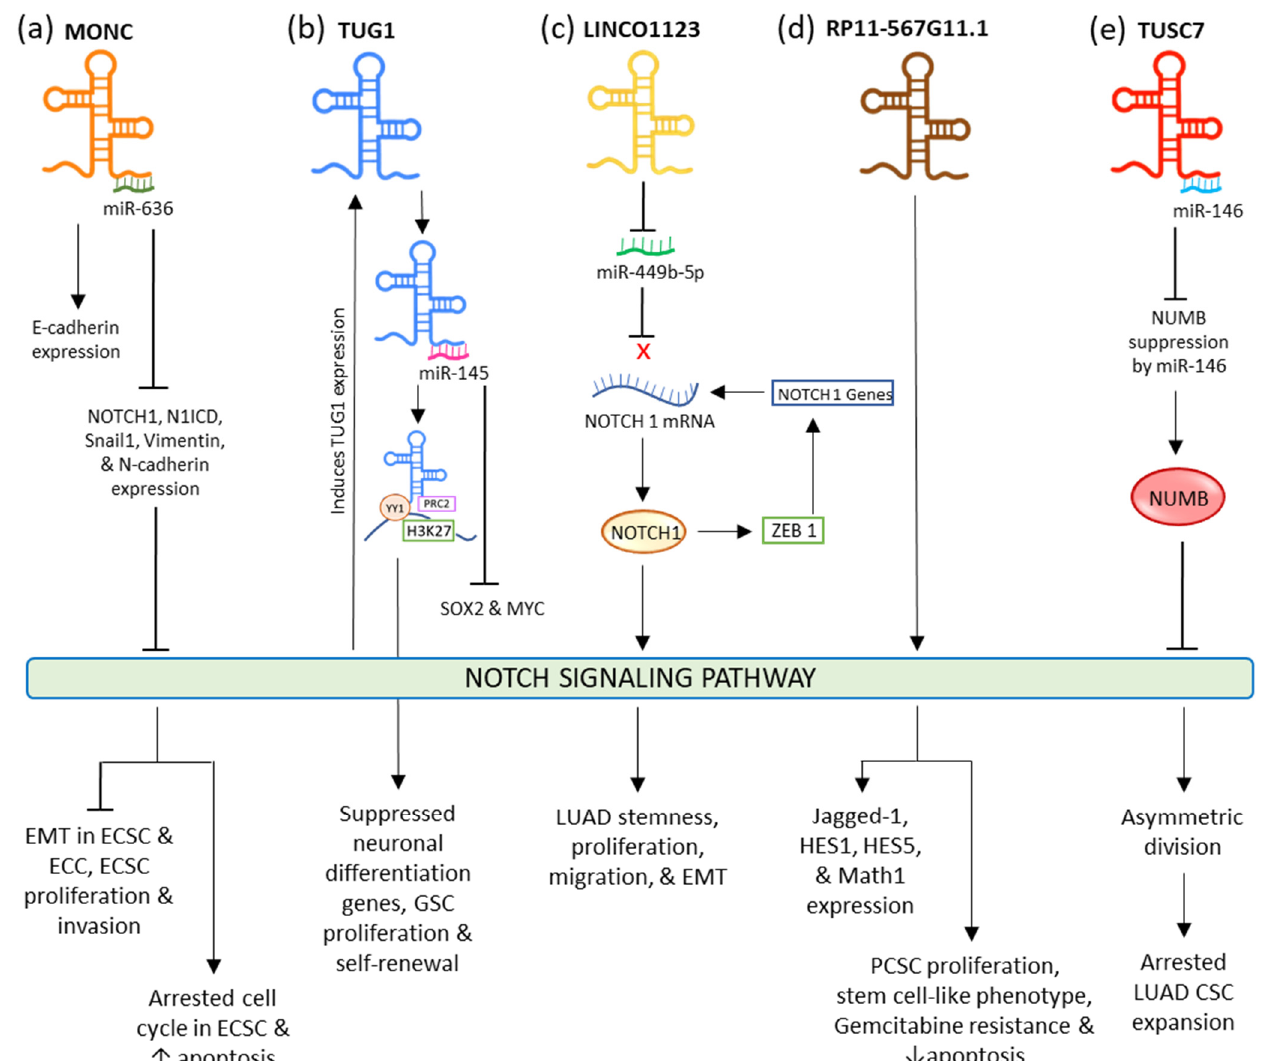
Figure 2. Interaction of different lncRNAs and lincRNA with NOTCH signaling pathway.